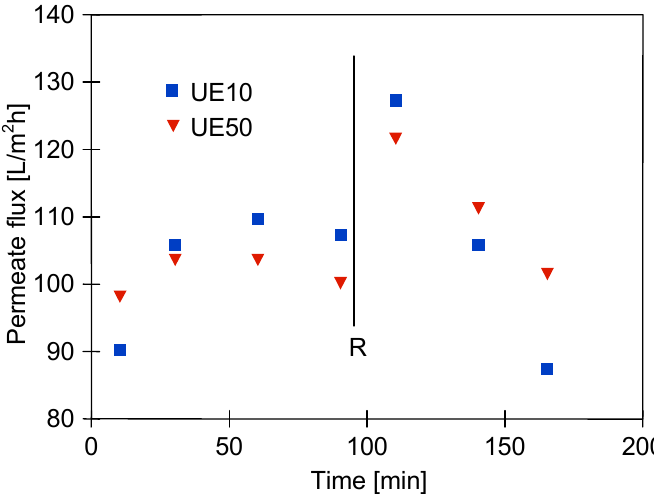
Figure 6. Changes in the permeate flux during UF of blue + wax solution. R—modules cleaning is presented in Figure 7. TMP = 0.2 MPa, feed flow velocity: 1 m/s.